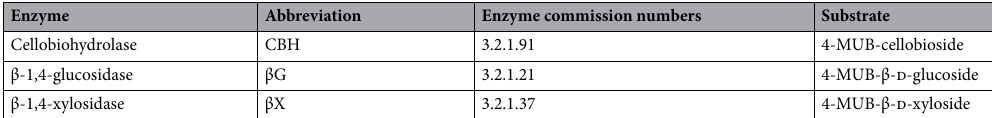
Table 1. The enzyme commission numbers and hydrolysis substrates of soil carbon cycle-associated enzymes. 4-MUB: